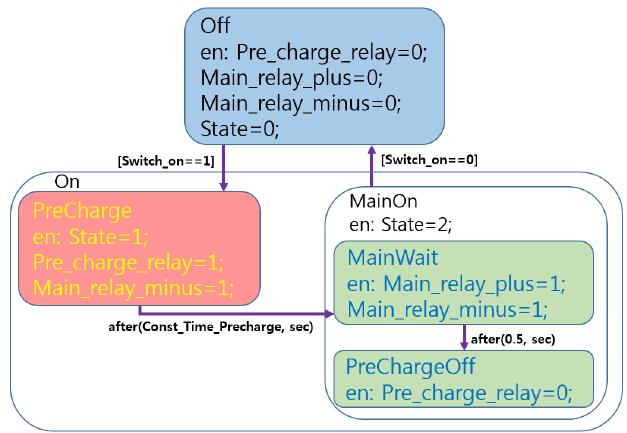
Figure 8. State-Flow chart.